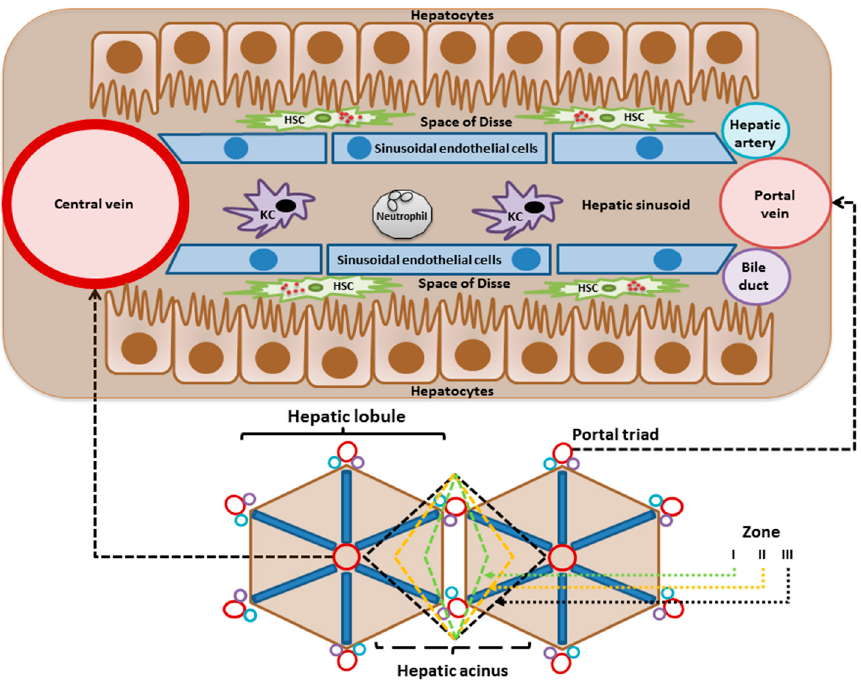
Figure 1. Structure and cell types of a normal liver. HSC, hepatic stellate cells; KC, Kupffer